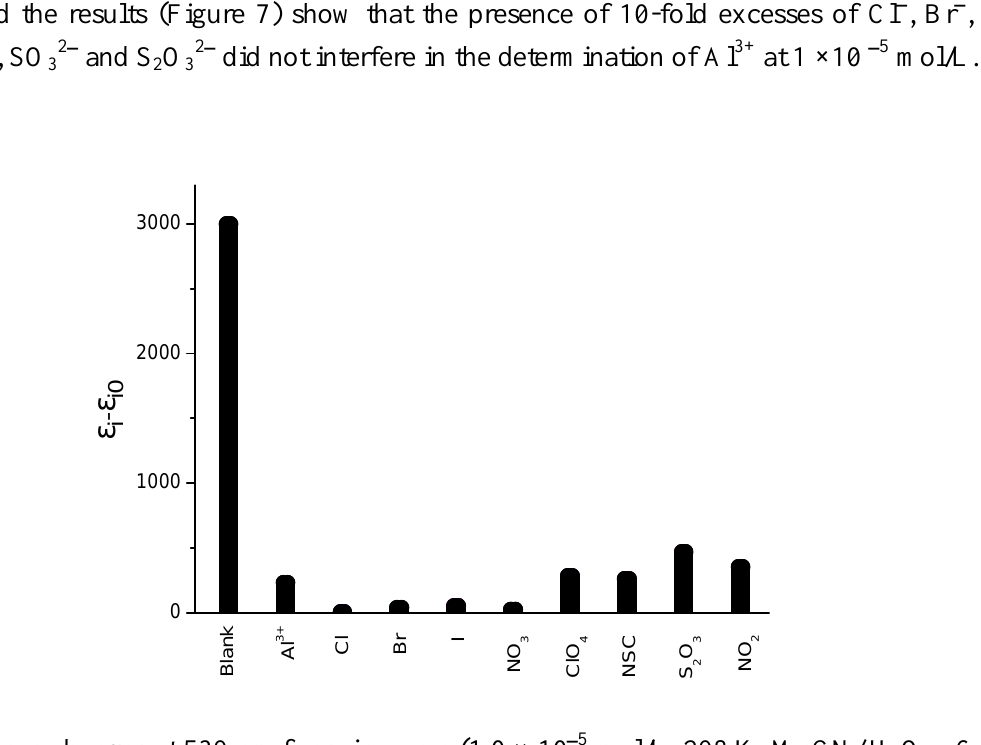
Figure 7. Absorbance changes at 539 nm for spiropyran (1.0 × 10  5 mol/L, 298 K, MeCN/ H V/V) with irradiation for 10 min at 365 nm light in the absence of Al 3+ (blank sample), and in the presence of Al 3+ (Al 3+ ) or with other common anions (1 eq). Note: ε 539 nm with different anions without irradiation in the presence of Al 3+ ; ε at wavelength 539 nm with different anions with irradiation for 10 min at 365 nm in the presence of